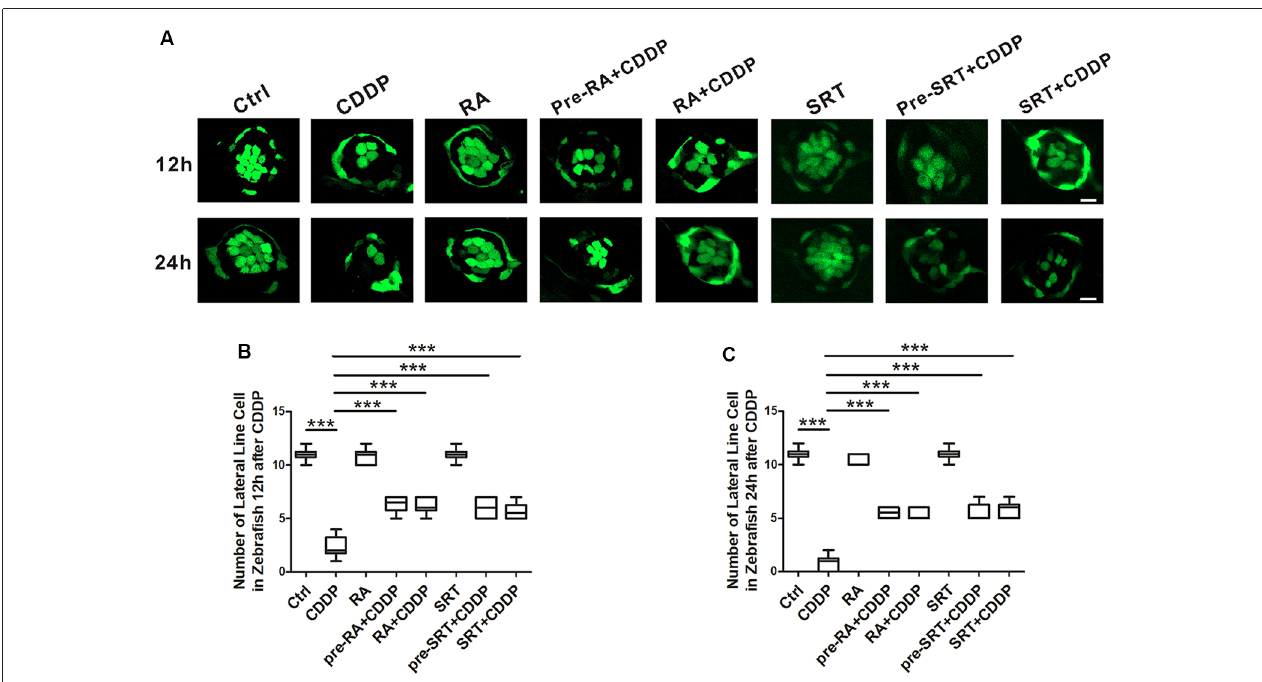
FIGURE 5 | Autophagy activation promotes hair cell survival after cisplatin-induced damage in zebrafish lateral line. (A) Hair cell counts obtained from CDDP exposure for 12 or 24 h with or without RA or SRT1720 treatment ( n = 6 zebrafish larvae). Scale bar, 10 µ m. (B) The hair cells were counted at 12 h after CDDP exposure. (C) The hair cells were counted 24 h after CDDP exposure. Data represent the mean ± SEM. ∗∗∗ p < 0.001. Control, zebrafish larvae cultured in the same dose DMSO as the CDDP and RA group; RA, zebrafish larvae cultured in RA; CDDP, zebrafish larvae cultured in CDDP; pre-RA+CDDP, zebrafish larvae cultured in RA for 1 h followed by exposure to CDDP; RA + CDDP, zebrafish larvae cultured in CDDP and RA. SRT1720, zebrafish larvae cultured in SRT1720; pre-SRT1720+CDDP, zebrafish larvae cultured in SRT1720 for 1 h followed by exposure to CDDP; SRT1720 + CDDP, zebrafish larvae cultured in CDDP and SRT1720. CDDP, cisplatin; RA, rapamycin; SRT,